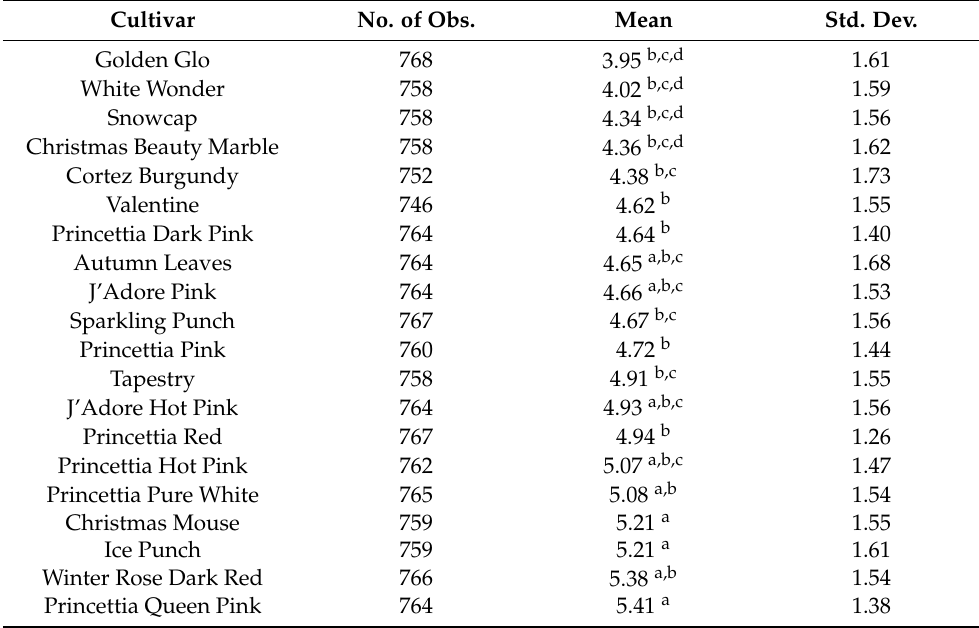
Means denoted by the same letter indicate no significant differences between pot sizes ( p ≤ 0.05). Table 3. Willingness to pay for three poinsettia cultivars by color. Pot Size No. of Obs. Mean Std. Dev. White 1972